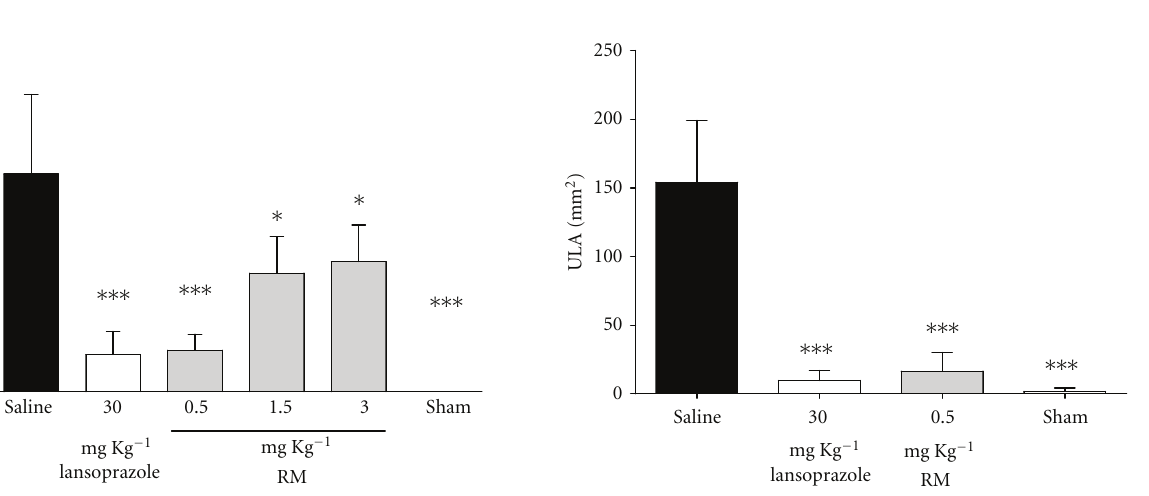
Figure 3: E ff ect of pretreatment with RM on ischemia-reperfusion- induced gastric ulcer in rats. The animals received 0.9% saline solu- tion (vehicle), lansoprazole (30mgkg − 1 ), and RM (0.5mgkg − 1 ); sham group represents the manipulated animals. The results are expressed as mean ± s.d. ( n = 8), and statistical significance was determined by one-way analysis of variance (ANOVA) followed by Dunnett’s post hoc t test, with the level of significance set at P < 0 . 001 ∗∗∗